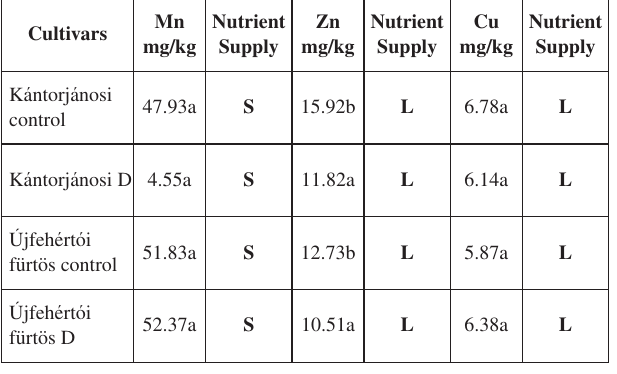
Legend: L-low, S-sufficient In each column, means followed by the same letter are not significantly different (P<0.05).